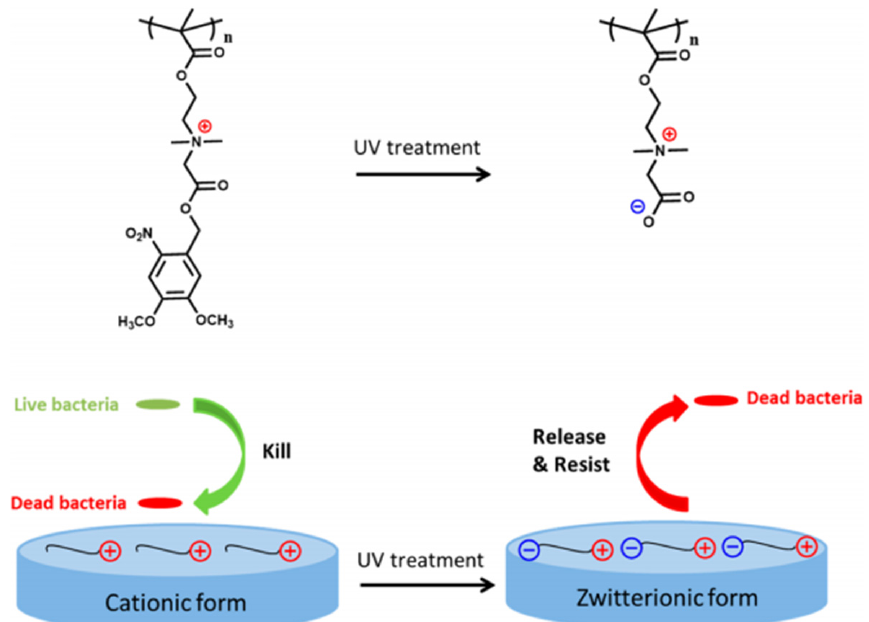
Figure 19. A schematic illustration of poly[2-((4,5-dimethoxy-2-nitrobenzyl)oxy)-N-(2-(methacryloyloxy)